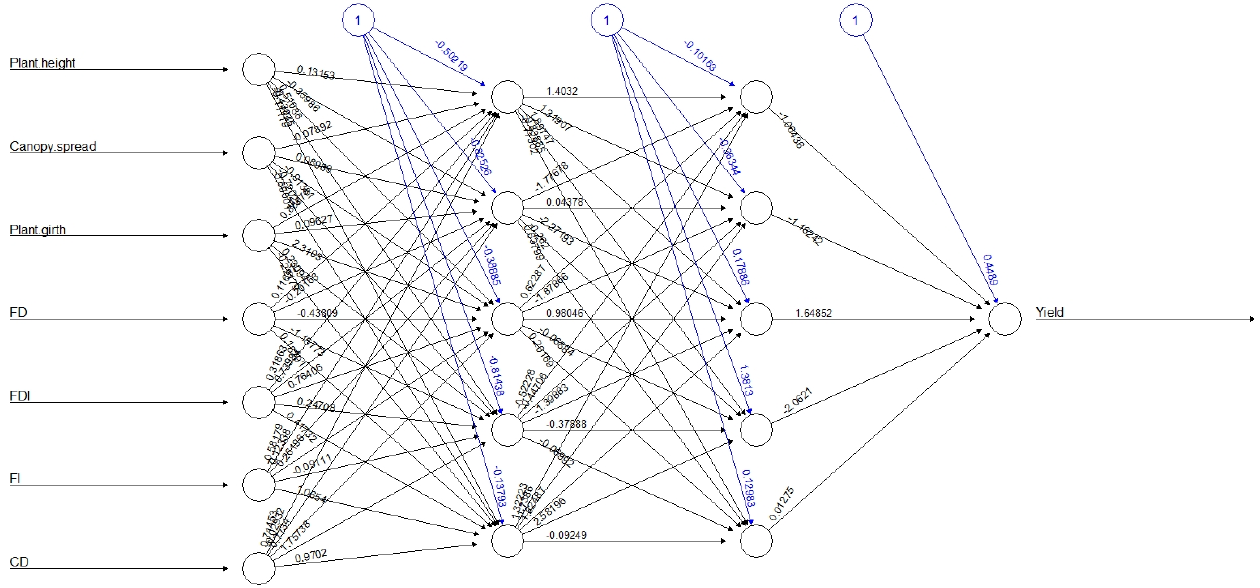
Figure 1. Topology of neural network model for Apple yield prediction.